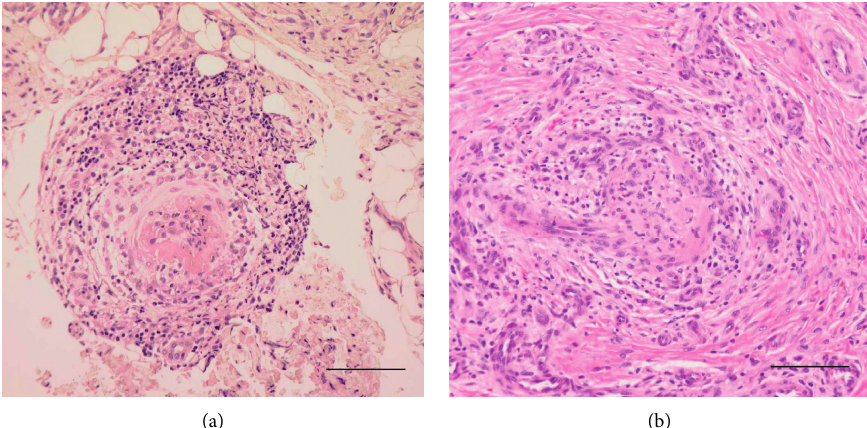
Figure 1: Histopathological findings from synovial tissue (a) and cutaneous tissue (b). The pathological specimens, which were stained with hematoxylin and eosin, display fibrinoid necrosis and luminal occlusion in the arteries as well as inflammatory cell infiltration (scale bar � 100 μ